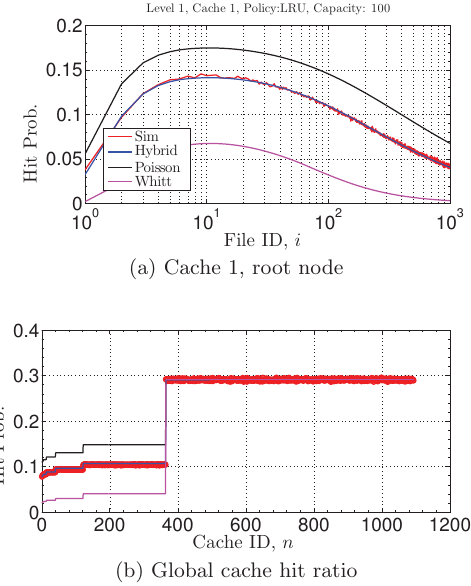
Figure 6: Simulations (Poisson arrivals on leaves and Zipf popularity). Poisson, Whitt, and Hybrid approximations. Ternary tree of LRU caches, Depth 7, K = 10 3 , C =